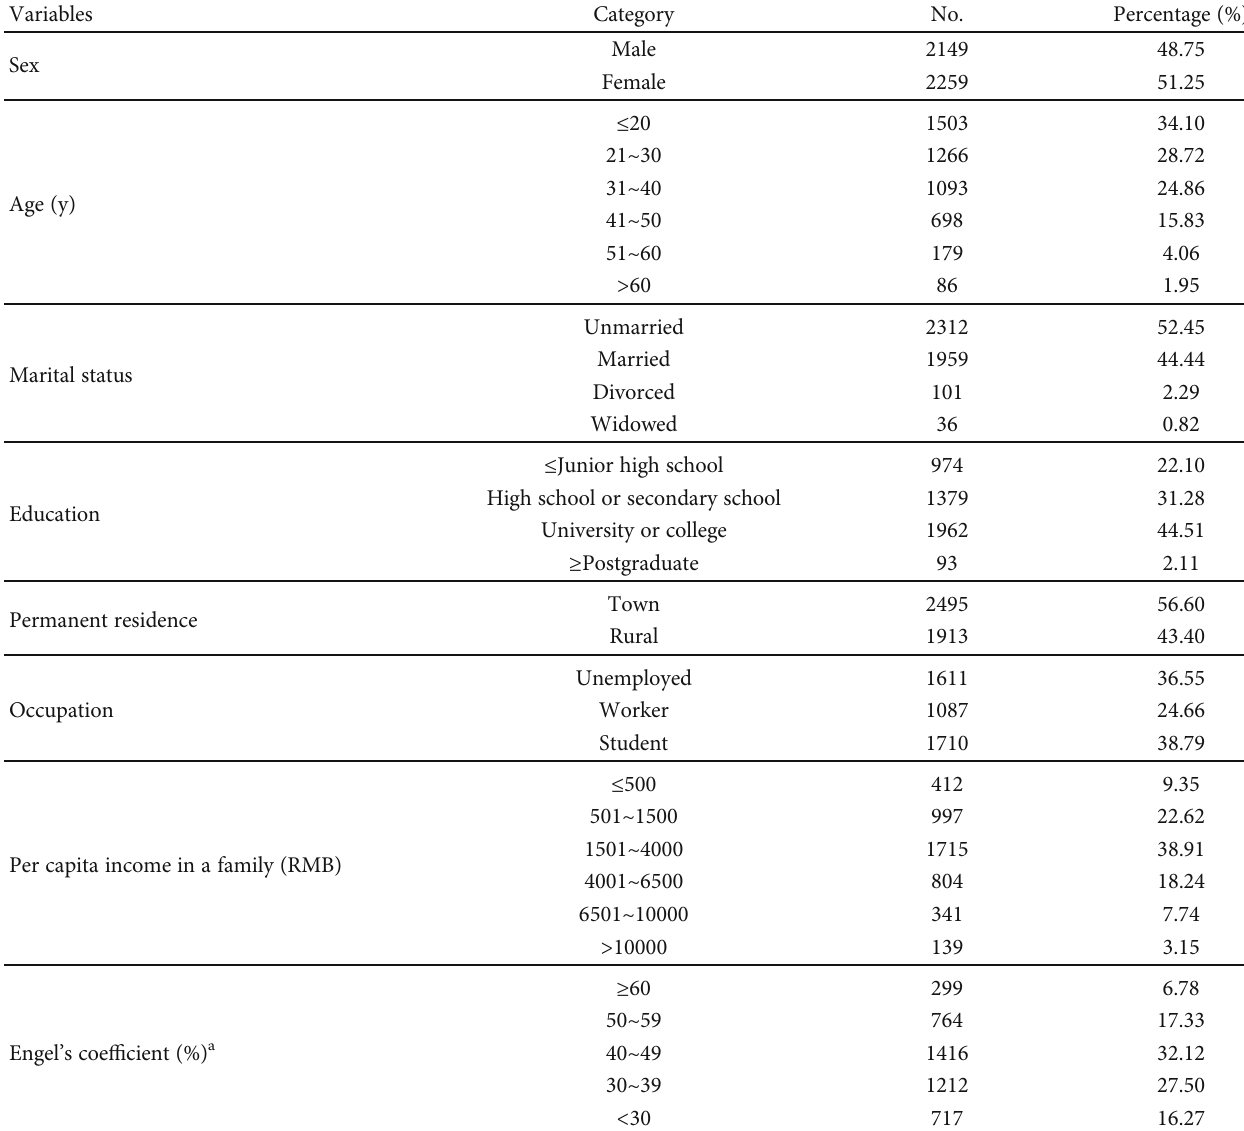
Table 1: Demographic characteristics of the respondents ( n = 4408